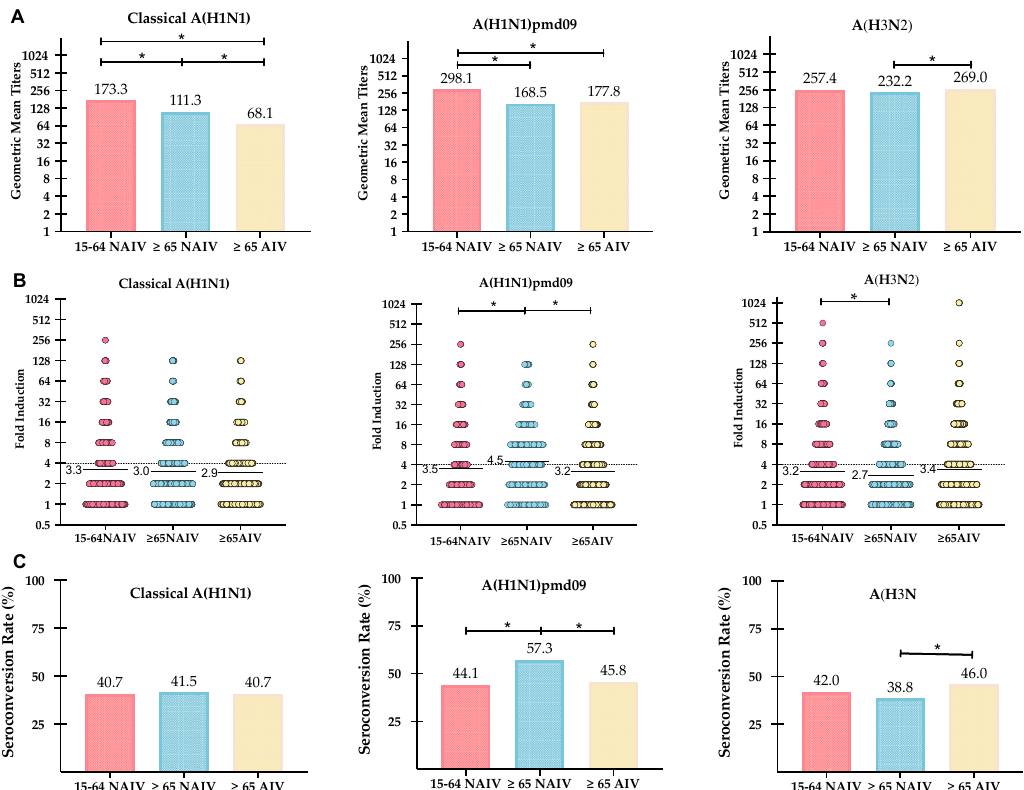
Figure 2. Plots analyzing the e ff ect of the vaccine on the three di ff erent age groups for all of the influenza A subtypes analyzed. ( A ) Post vaccination GMT values. ( B ) Individual fold-induction (post / pre-HI titers) marked in dots, and the GMT increase marked with a line. ( C ) Seroconversion rate (percentage of population with 4-folded initial HI titers). Statistical signification between cohorts ( p < 0.05) is marked with a line and * in all plots.